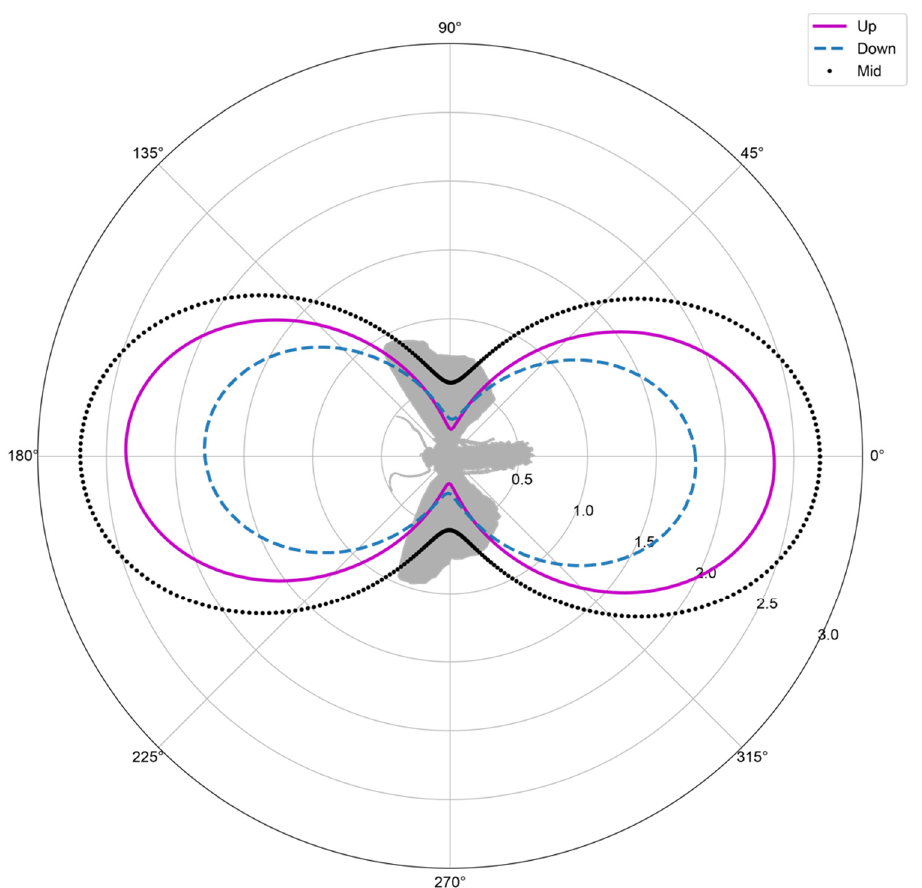
Figure 11. Comparison of the modelled polarimetric RCSs (cm 2 ) showing the results for a model with the three different wing positions: Up, Mid and Down shown in Figure 5. The shadowed model is not to scale and for orientation purposes only.